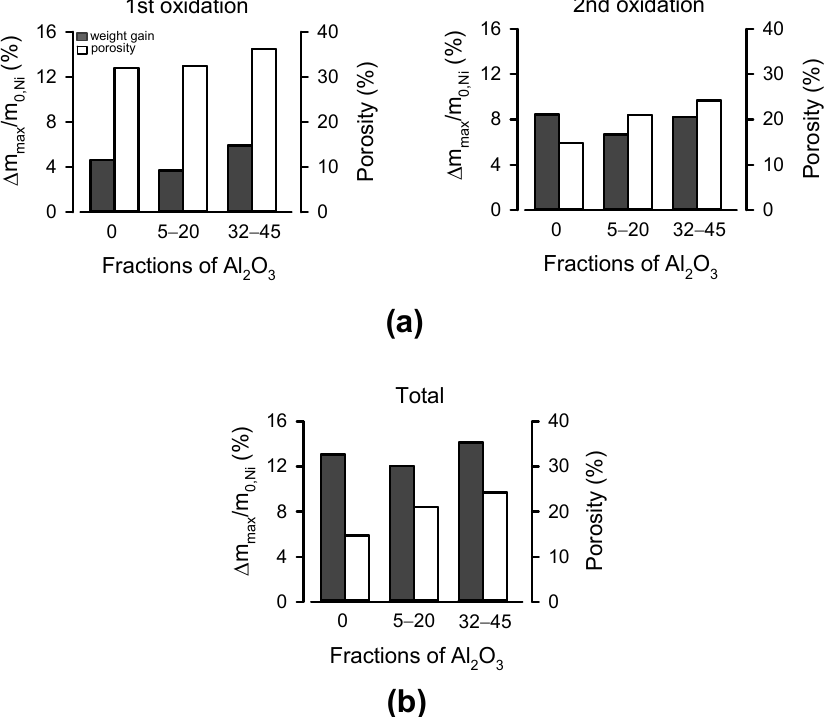
Figure 6. Comparison of the final relative weight gain (black column) of samples and the open porosity (white column): ( a ) after the first and second oxidation cycles; ( b ) summary after two oxidation cycles.